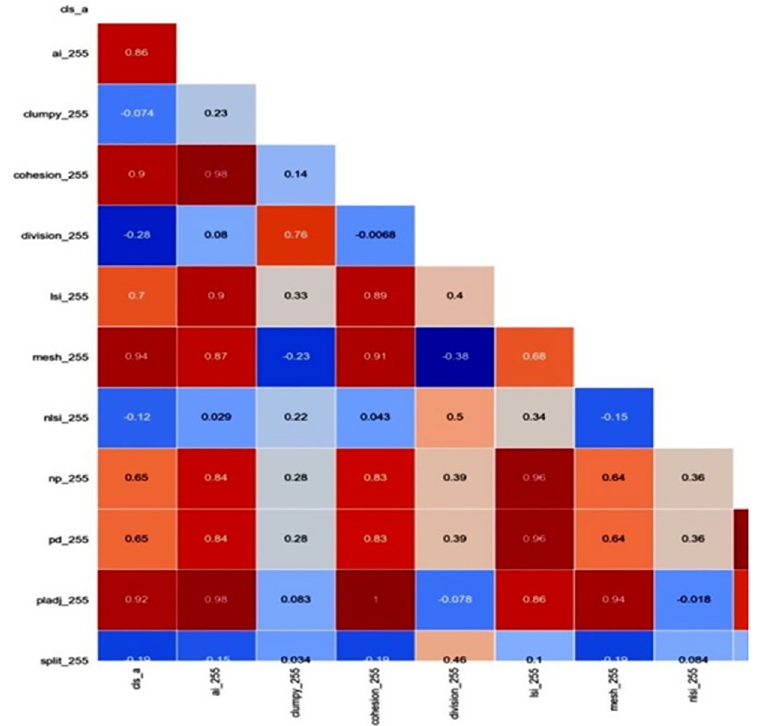
Fig 7. The Percentage of Like Adjacency index (PLADJ) showed high correlation coefficient in the Heat map. https://doi.org/10.1371/journal.pone.0275928.g007 Table 1. Description of the spatial metrics used in this study (McGarigal et al. 2002). Factors Spatial metrics Units Range Mangrove canopy Contiguity Index (CONTIG) width CONTIG